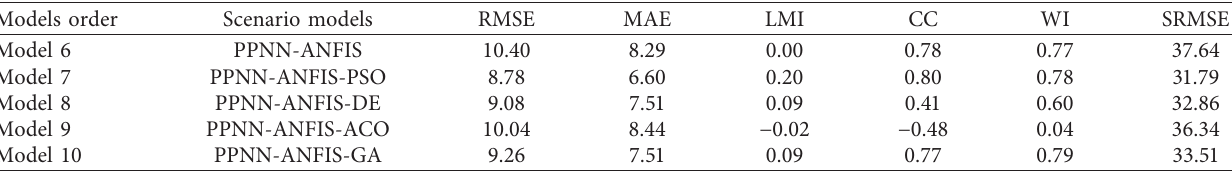
Table 3: The statistical evaluation of the developed hybrid and original ANFIS for the scenario of the preprocessed and nonnormalized (PPNN) dataset over the testing phase of the modeling.